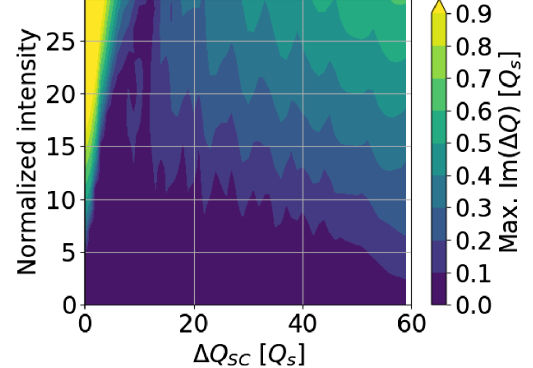
.FIG. 8. Maximum imaginary tune shift for a Gaussian distri- bution obtained with 100 slices and 50 rings for different strengths of the wakefields and the space charge